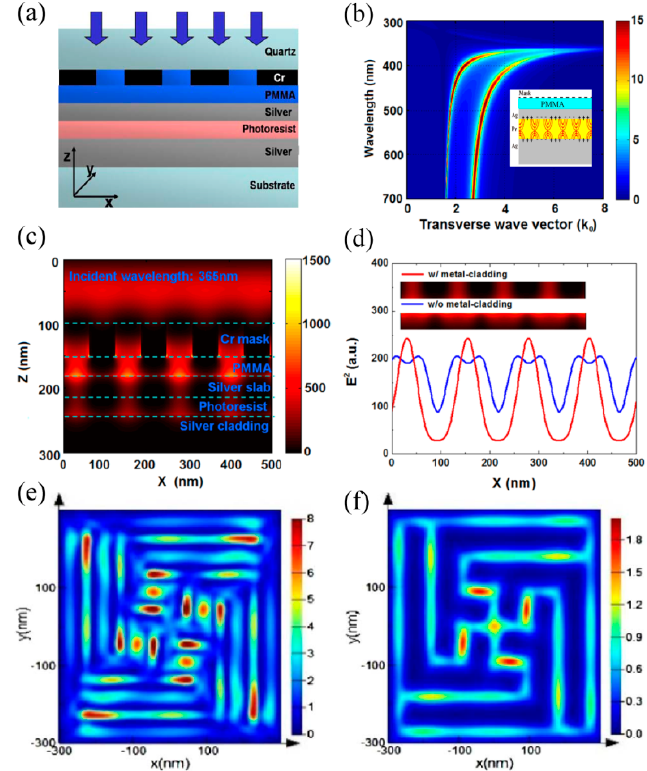
Figure 28. ( a ) Schematic structure of plasmonic cavity lens lithography; ( b ) H-field amplitude at the interface of the Ag superlens and photoresist as a function of the optical wavelength and the transverse wavevector through the plasmonic cavity lens structure, inset is the approximately mirror-symmetric distribution of surface charges; Simulation results of the object with ( c , d ) 62 nm and ( e , f ) 45 nm resolution. Reproduced from: (a–d), [55], Copyright © 2009, Springer; (e,f), [112], Copyright © 2013, OSA.